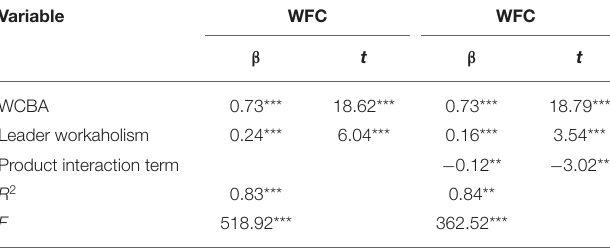
TABLE 4 | The moderating role of leader workaholism.